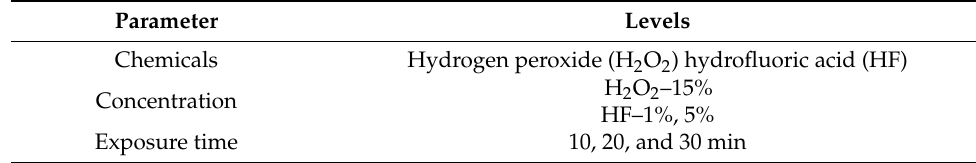
Table 1. Details of chemical treatment.